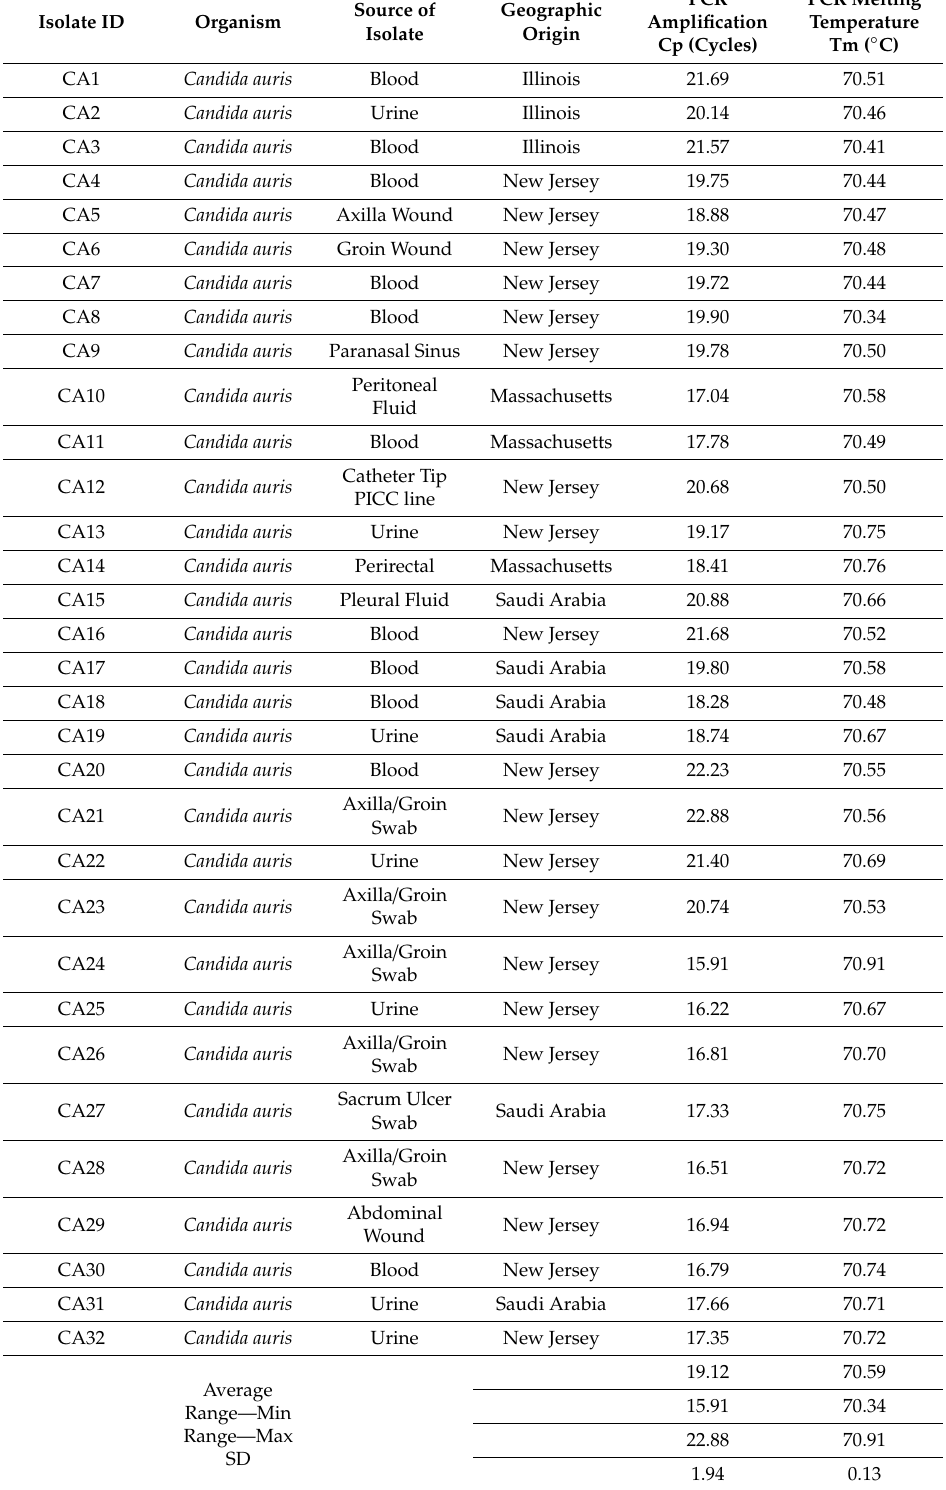
Table A1. Candida auris isolates used to evaluate the PCR